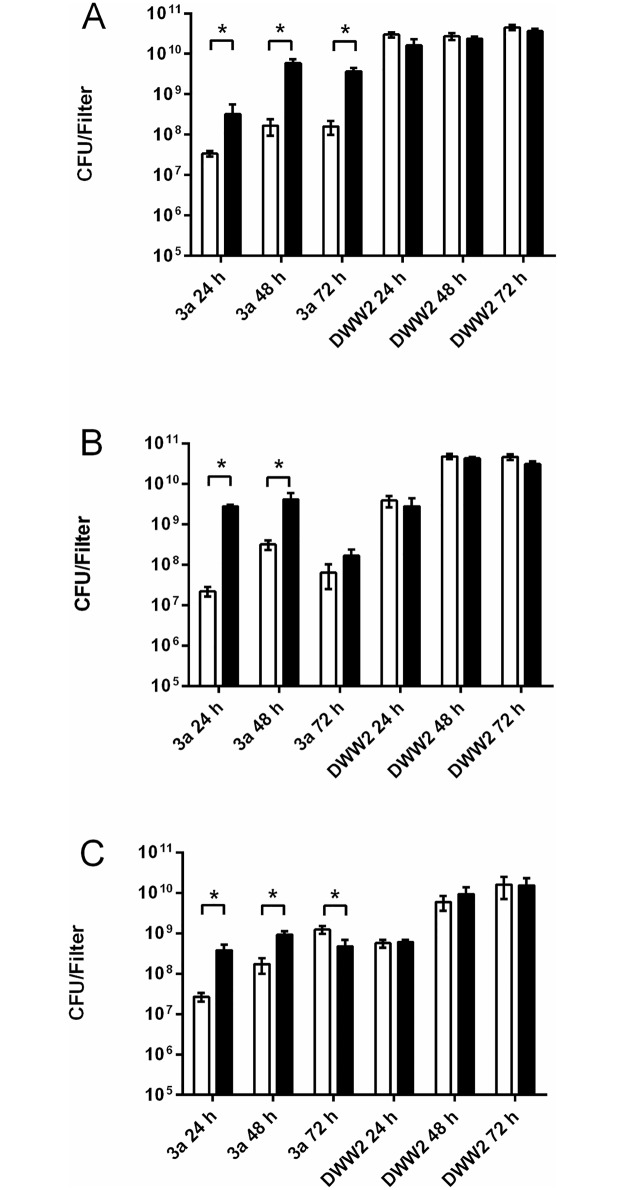
Quantitative bacteriology of biofilms.CFU/filter of monoculture (open bars) and co-culture (black bars) biofilms of Pseudomonas aeruginosa strain DWW2 and Streptococcus anginosus strain 3a at 24hrs, 48hrs and 72hrs grown in normoxic (air) (A), 10% CO2 (B) and anoxic (10% H2, 10% CO2, 80% N2) (C) environments. Data values are mean CFU per biofilm ± SD of 4 independent biofilms. Statistical analysis of bacterial counts obtained for strain 3a and DWW2 in mono-culture and in co-culture for each time point were by two-tailed Mann-Whitney U test: * = p<0.05.